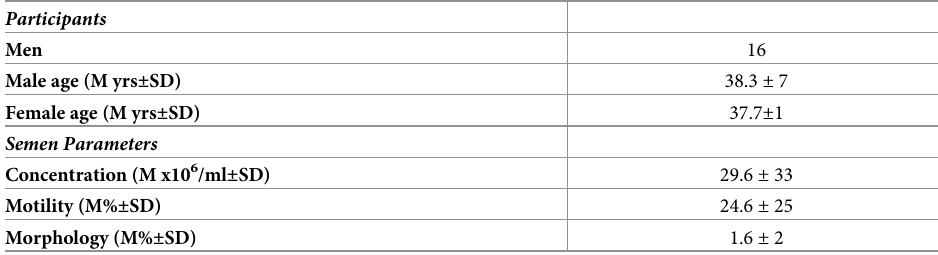
Table 2. Characteristics of couples and semen specimens screened by NGS